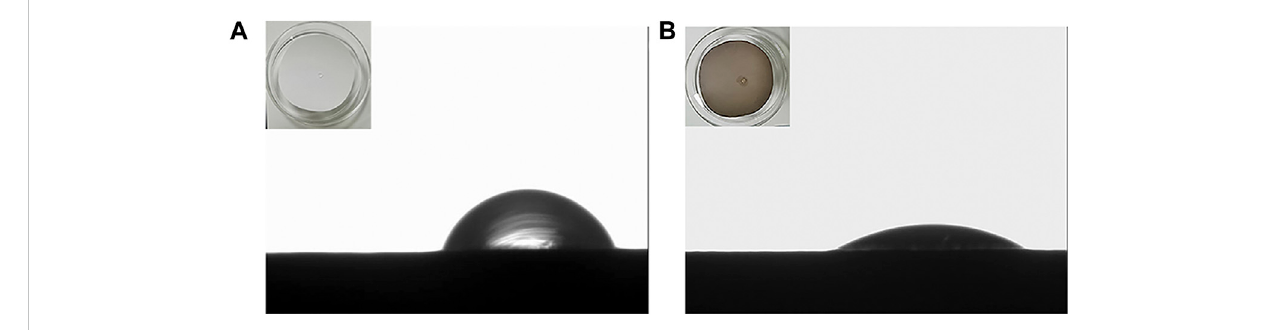
FIGURE 5 Contact angle images: (A) PVDF membrane and (B) PVDF/DA membrane.